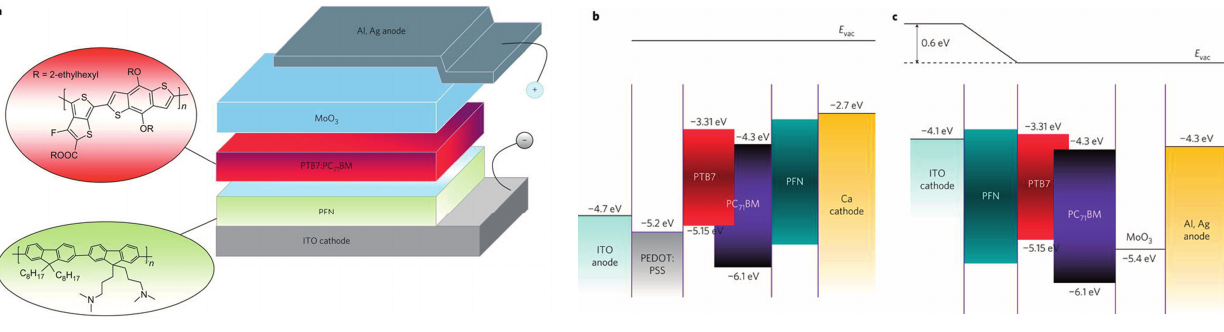
Figure 7. Schematic illustration of the inverted PTB7:PC 71 BM PSCs, in which the photoactive layer is sandwiched between a PFN-modified ITO cathode and an Al, Ag-based top anode ( a ). Schematic energy levels of the conventional ( b ) and inverted ( c ) devices under flat band conditions. Note that the formation of a positive interface dipole moment (taking the dipole moment directed outwards to be positive) is presented in the inverted cells. Reprinted with permission from [26]. Copyright 2012 Nature Publishing